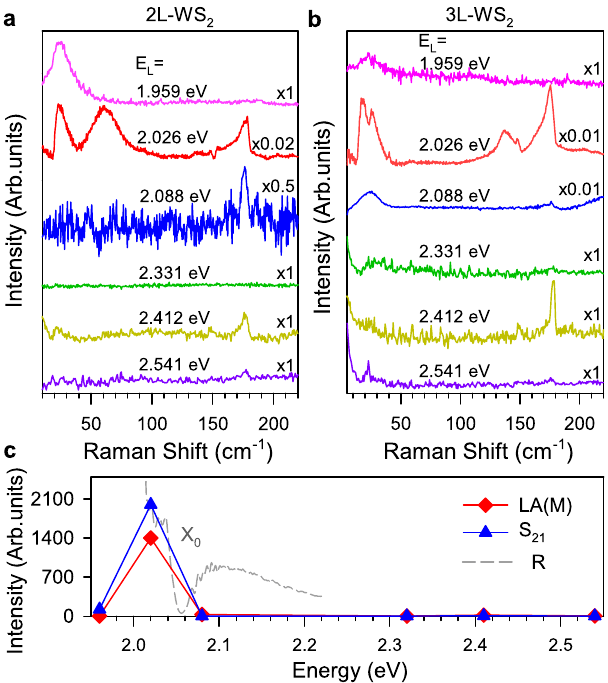
Fig. 3 | Excitation energy dependence of quantum interference. a, b Raman spectraof2L-and3LWS 2 underdifferentexcitationenergies(E L )at4K,respectively. TheintensitiesarenormalizedtotheRamanmodesofsiliconsubstrate(524cm − 1 at4 K).Thedataareoffsetforclarity. c TheintensityofshearandLA(M)modesrespectto the excitation energies. The dotted gray line is the re fl ection spectrum of 2L-WS 2 .